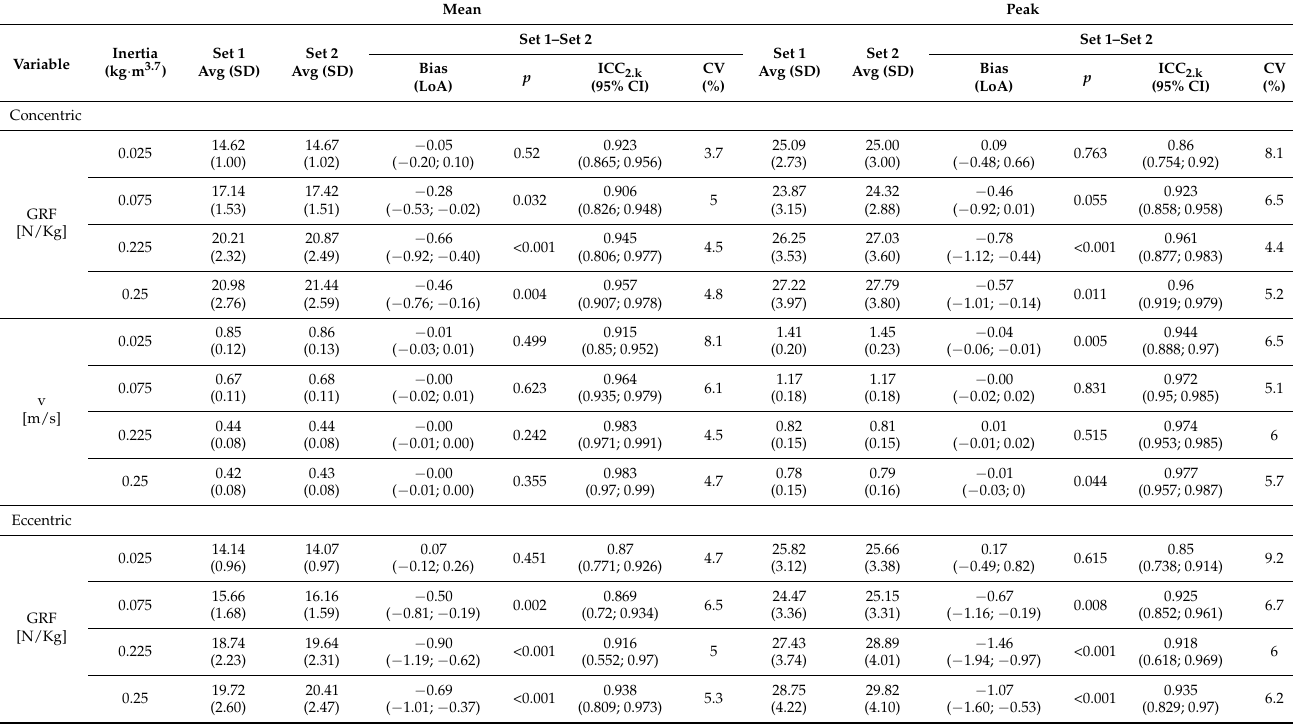
Table A2. Descriptive statistics and inter-set reliability of the observed force plates (GRF) and linear encoder variables